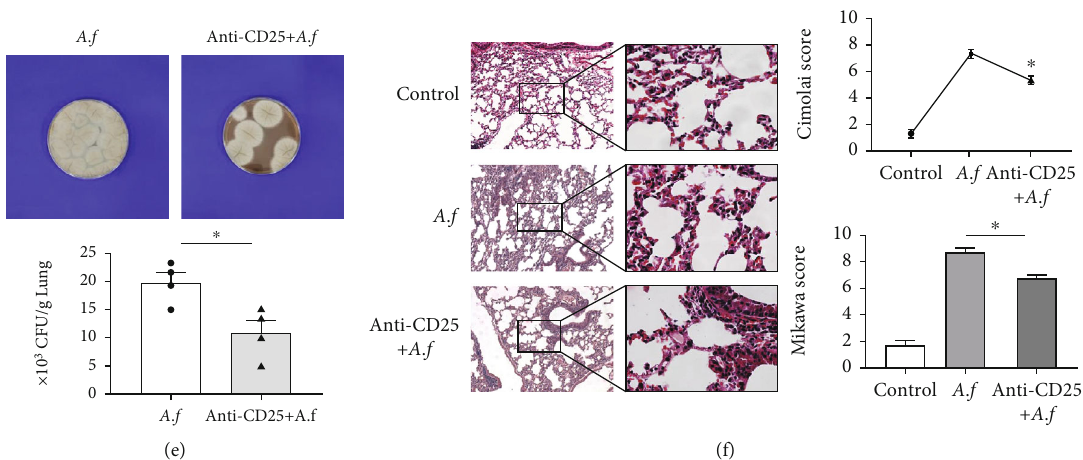
Figure 2: The persistent presence of fungi in lung injury induced by Aspergillus fumigatus is related to Tregs. (a) Increased CD4 + CD25 + Foxp3 + Treg proportion signi fi cant in PBMCs of patients infected with A. fumigatus ( n = 7 ). (b) Foxp3 mRNA levels in the lungs were measured with q-PCR. Relative expression levels of the genes were expressed with the GAPDH housekeeping gene as an internal reference ( n = 5 /group). The expression of Foxp3 protein levels in the lungs was measured with Western blotting. Relative expression levels were expressed with the GAPDH as an internal reference ( n = 3 /group). (c) CD4 + CD25 + T cells and CD4 + CD25 + Foxp3 + Tregs in the spleen were detected by fl owcytometry, and FlowJo10 analyzed the proportions as prior described in Section 2. Increased CD4 + CD25 + T cell and CD4 + CD25 + Foxp3 + Treg proportion signi fi cantly in the spleen of A. fumigatus infection mice ( n = 5 /group).Decreased susceptibility of mice to A. fumigatus infection after Treg depletion. (d) After pretreatment with CD25-neutralizing antibodies, the number of Treg cells in the spleen of mice with A. fumigatus infection group was signi fi cantly reduced, each group ( n = 5 /group). (e) Fungal load (colony-forming unit) after 1 day of infection ( n = 4 /group). Experiments were done at least three times. Data are presented as mean ± standard deviation. ∗ Statistically signi fi cant di ff erence ( p < 0 : 05 ) against noninfected control. (f) Lungs from each experimental group were processed for histological examination after H&E staining. Lung injury scores were evaluated by the method described previously. ∗ p < 0 : 05 , ∗∗ p < 0 : 01 , ∗∗∗ p < 0 : 001 , and ∗∗∗∗ p < 0 : 0001 by Student ’ s unpaired two-tailed t test and the one-way ANOVA followed by the Tukey post hoc test. Error bars represent